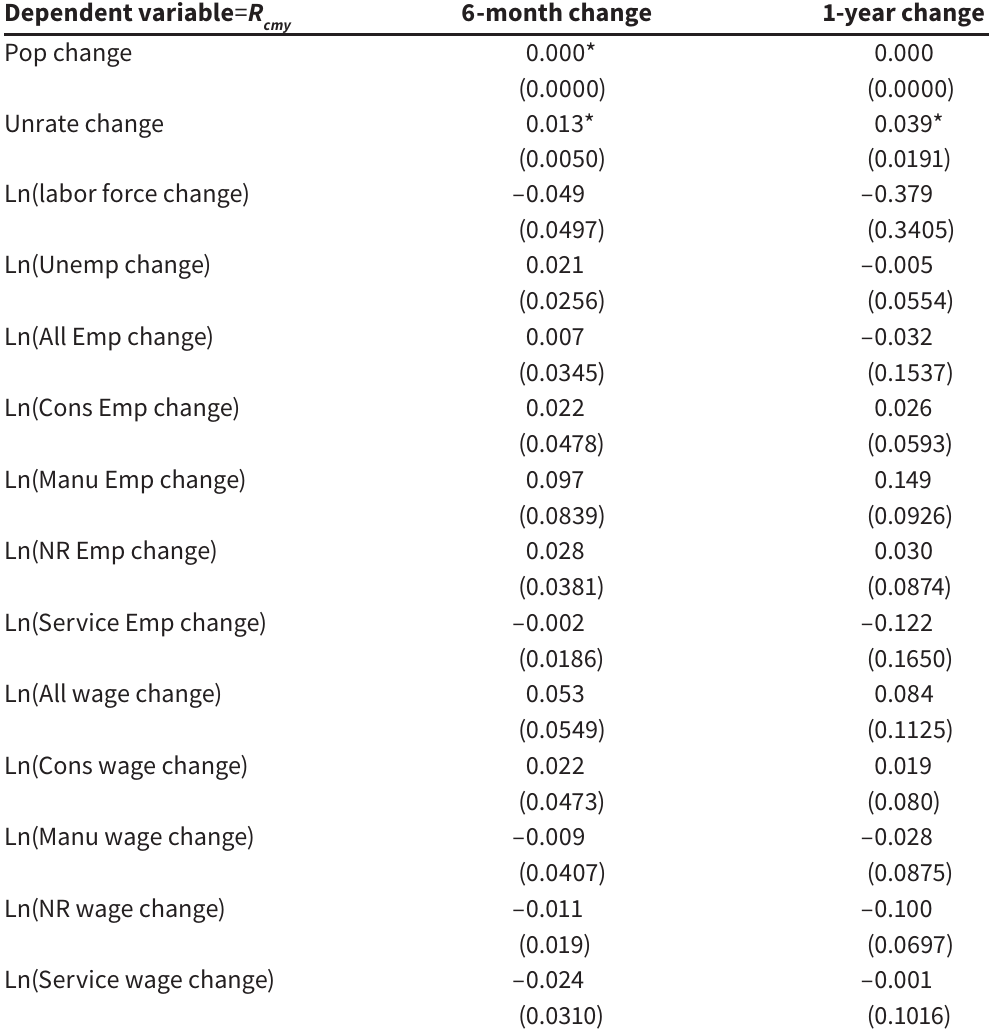
Effect of preexisting county-level economic conditions on dispensary